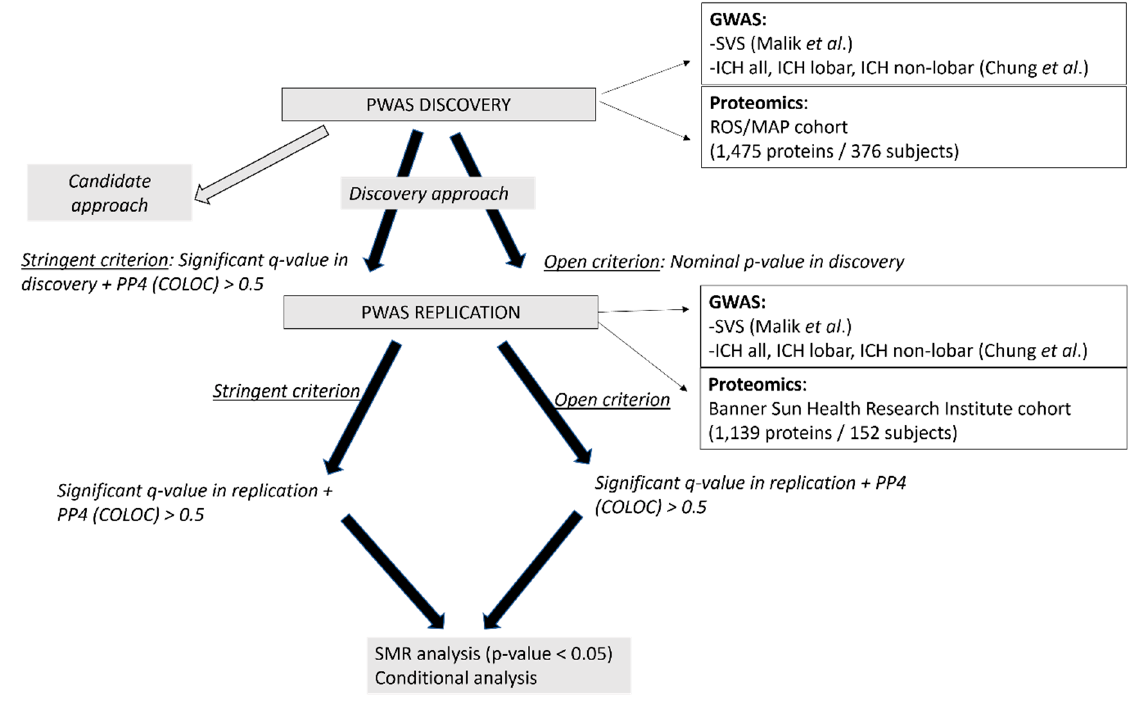
Figure 4. Schematic study workflow considering the discovery and the replication PWAS but also the sensitivity analyses.